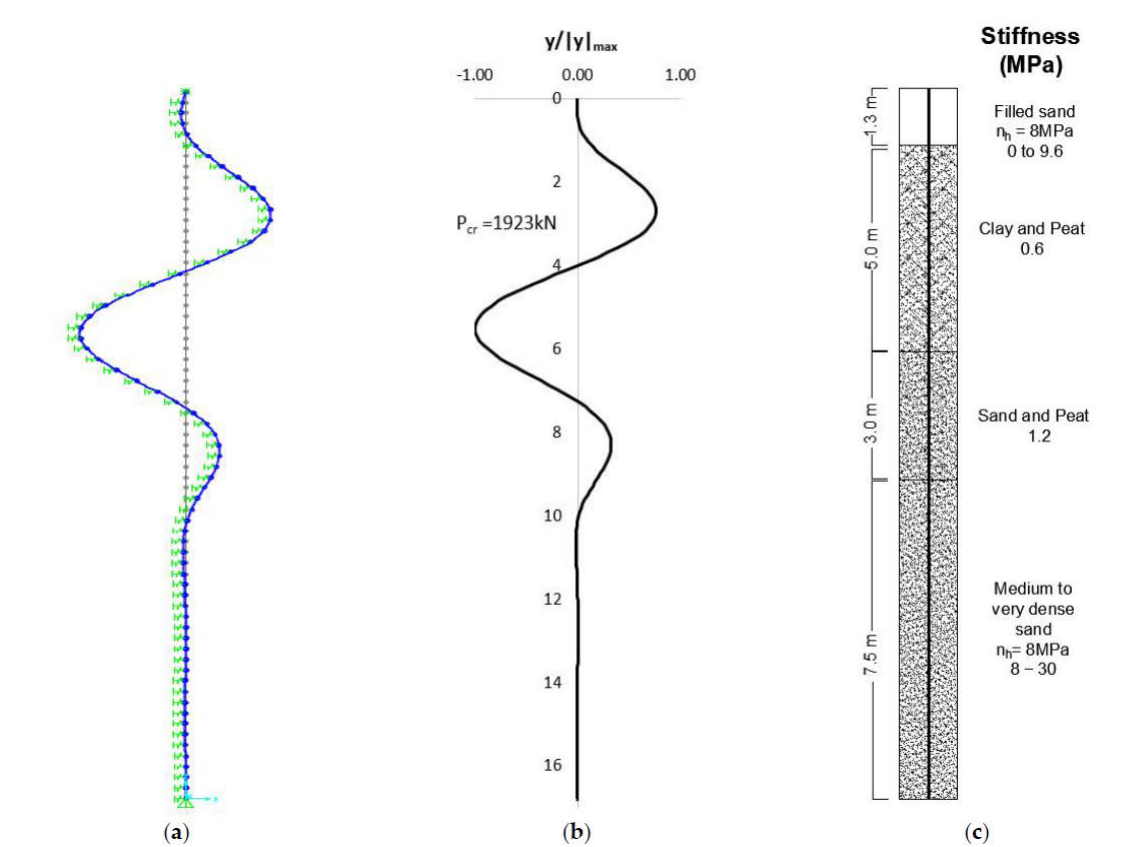
Figure 7. ( a ) Second-order displaced shape of Sap2000 buckling analysis model with horizontal springs correspondent to soil stiffness of that level. ( b ) Second-order displaced shape of analytical variational approach and buckling load of a pile in a multi-layered soil. ( c ) Configuration of the soil layers provided by